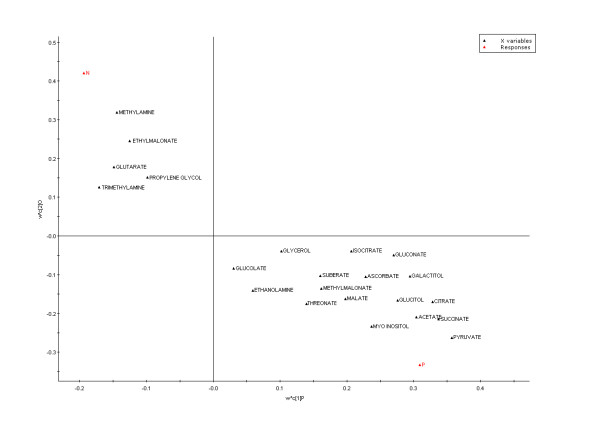
Biomarker detection. The loading coefficient map showing that myoinositol, glucitol, citrate, acetate, succinate and pyruvate were predominantly responsible for the classification of groups.